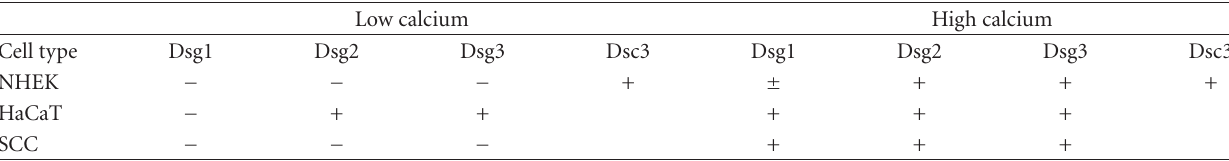
Table 1: Expression of desmosomal components by monolayers composed of di ff erent cell types cultured in low- or high-calcium medium. − : negative, ± : weak positive, +: